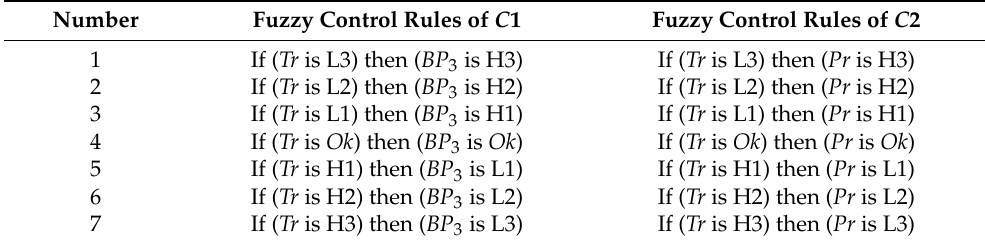
Table 3. Fuzzy control rules of controller.